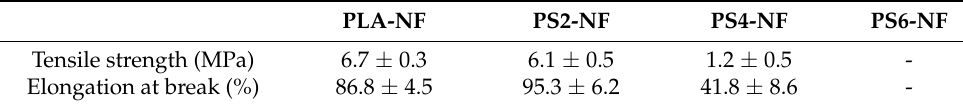
Figure 3. ( a ) SEM and ( b ) TEM images of PCNFs. 3.3. Fabrication and Characterization of PSCP-NF Besides the applied POSS and DEX@PCNFs, pearl powder was also incorporated in the nanofibrous scaffold. As shown in Figure 4, the SEM pictures of scaffold with pearl powder concentration of 5 wt%, 10 wt% and 15 wt% to PLA, as well as 2 wt% POSS and 1 wt% DEX@PCNFs, illustrated that the pearl powder and PCNFs could be distributed on the surface of the nanofibers without obvious influence on the nanofiber forming during the electrospinning process. In addition, the TEM pictures of PSCP5-NF (Figure 5) showed that pearl powder and PCNFs could also be wrapped inside the PLA nanofiber. Moreover, no fiber breakages were found due to the blending of these additives, despite the mor- phology of PLA-NF becoming a little rough to some degree. Benefitting the coverage of PLA shell, the release rate of DEX would further slowdown based on the controlled re- lease from PCNFs, which would decrease the waste of DEX along with body fluid flowing and prolonging the working period of DEX in the cells.